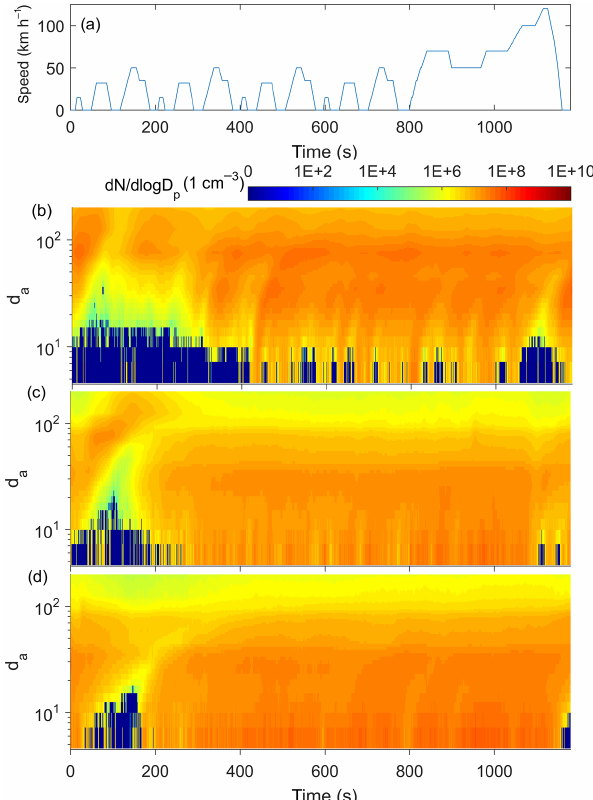
Figure 9. The number size distributions for the secondary particle emissions measured after the exhaust treatment by the PAM. The measurements were made during the driving cycle for all tested fu- els, E10 (b) , E85 (c) and E100 (d) . The driving cycle (NEDC) is shown in (a)